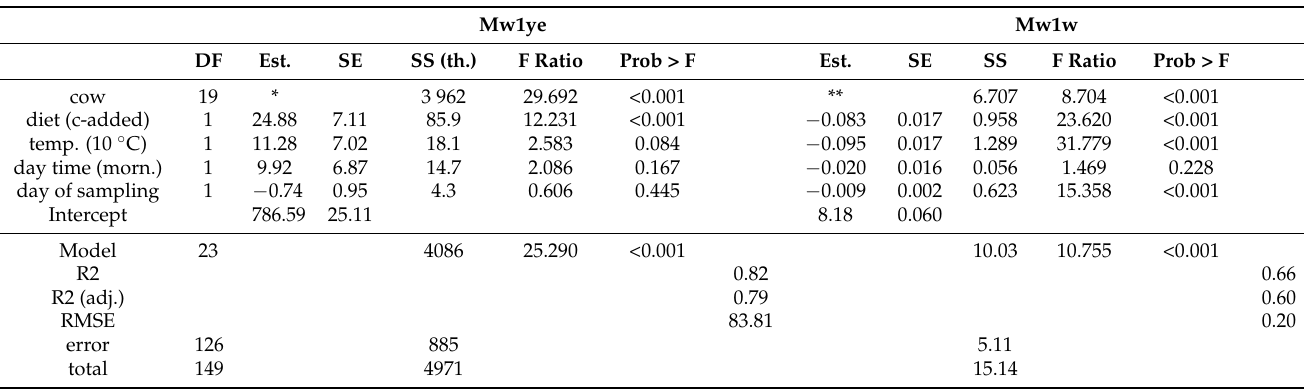
Table 4. Regression analysis of several experiment-related factors for the data variation of the EPs Mw1ye and Mw1w ( n =